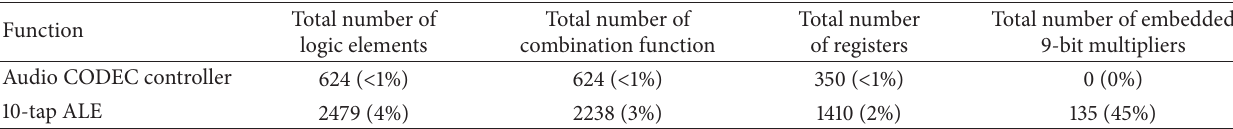
Figure 8: (a) The waveform of heart sounds mixed with wheezes. (b) The waveform after processing. Table 1: FPGA resource